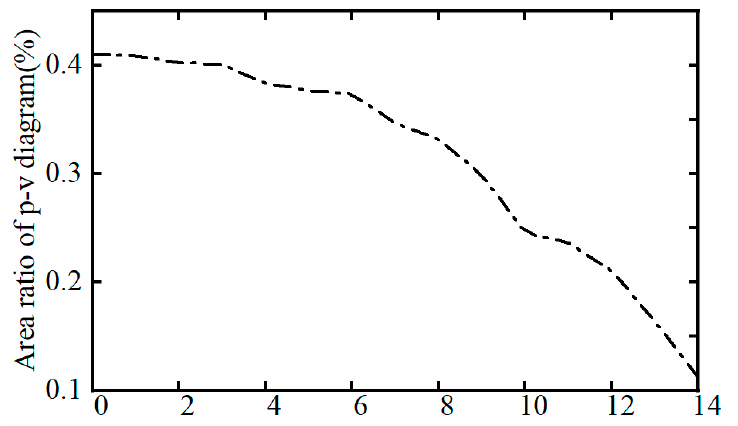
Figure 15. Area ratio of p-v diagram under different leakage diameters.